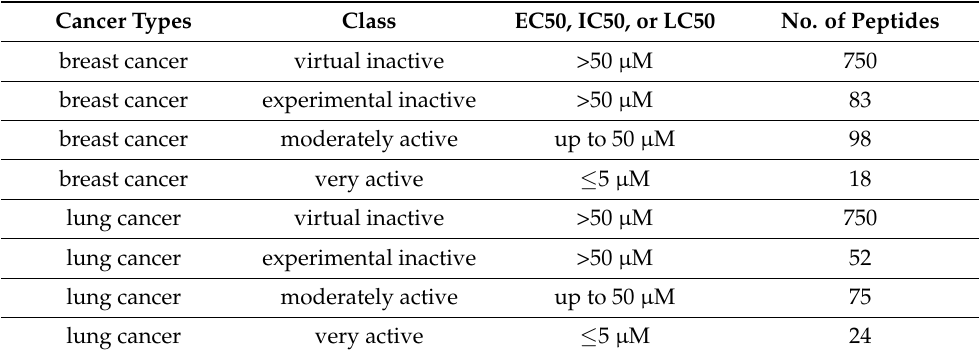
Table 2. Description of anticancer peptides